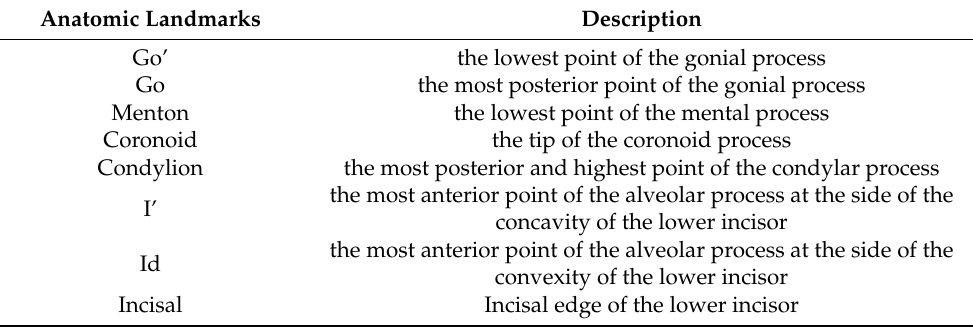
Table 1. Description of anatomic landmarks detected in Cone Beam CT reconstructed images.